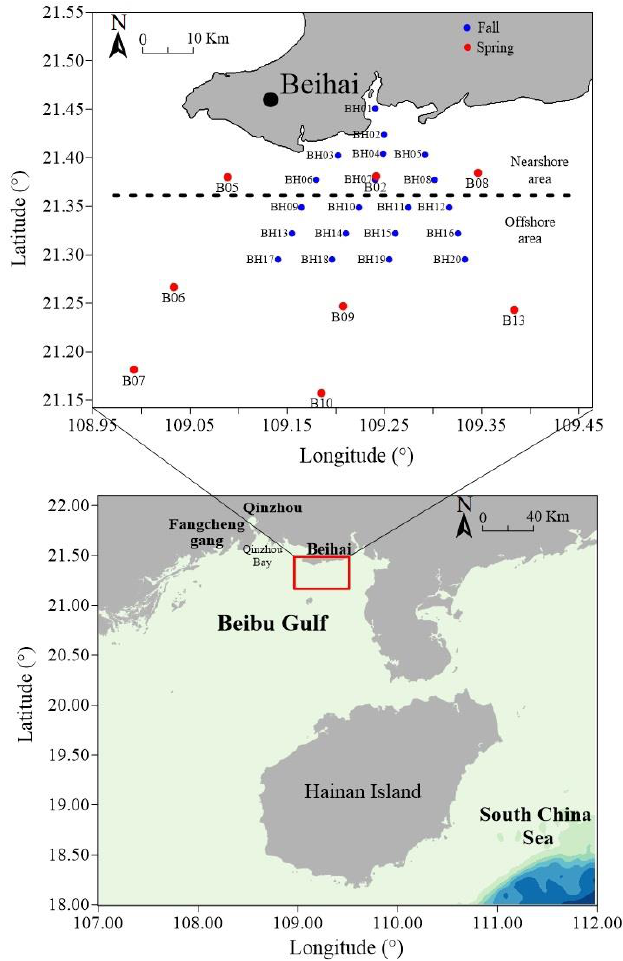
Figure 1. Location of the Beibu Gulf and sampling stations. The dashed black line in the upper figure separates the coastal area from the outer area.